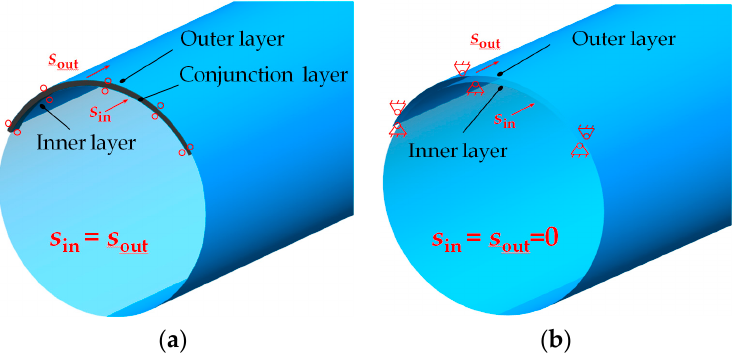
Figure 8. Schematic diagram of boundary conditions: ( a ) tied ends; ( b ) axial constraint ends.